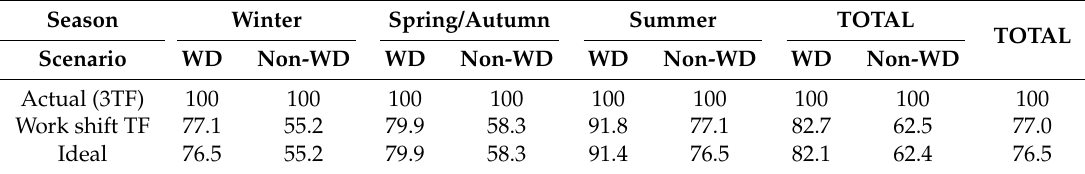
Figure 7. Monthly energy losses on Sec SS 3 with the three control systems of the number of transformers connected, considering that transformers fulfilled TIER1. Table 7. Percentage of losses with new transformers compared to the current connection (%).